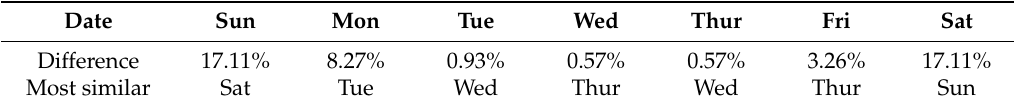
Table 7. Differences between days of the week.